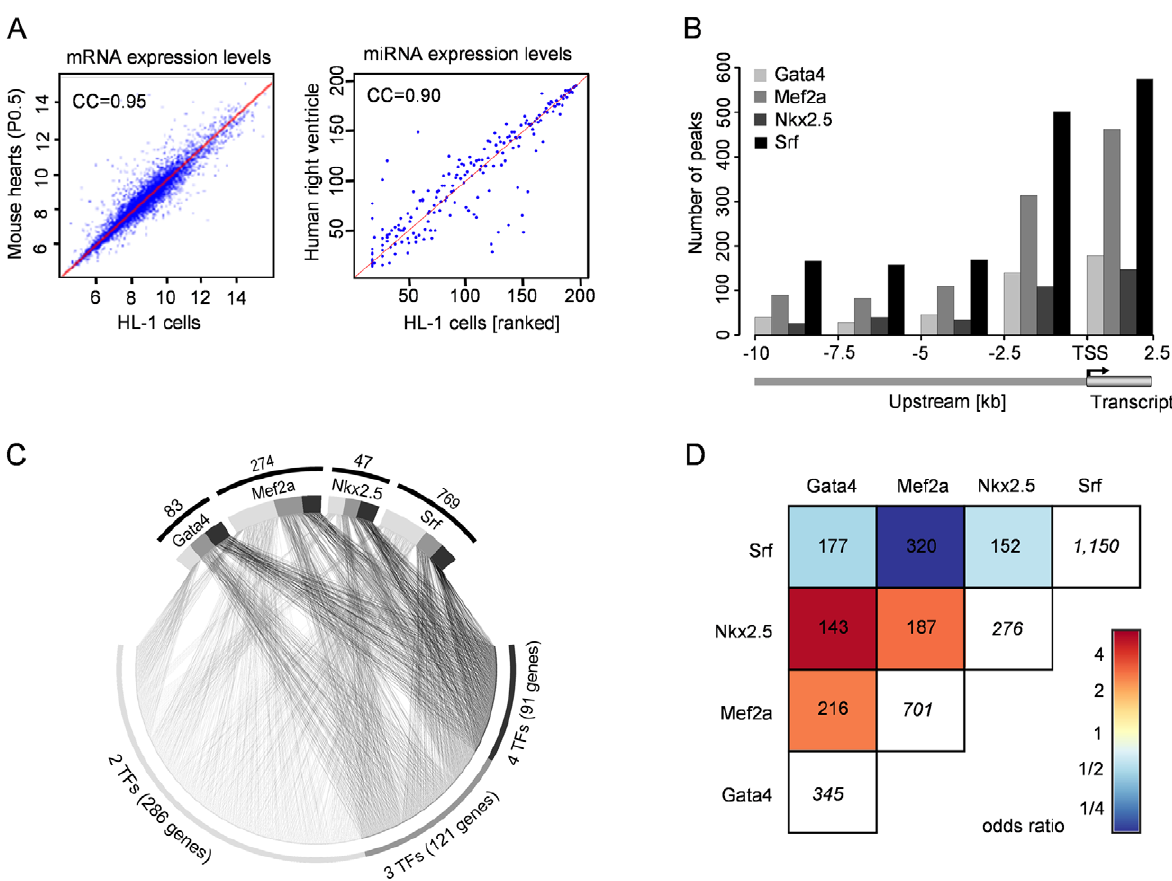
Figure 1. Binding site location and co-occurrence of Gata4, Mef2a, Nkx2.5, and Srf. HL-1 mRNA and miRNA expression profiles are highly comparable to the ones observed in human and mouse hearts. (left) Gene expression levels obtained from HL-1 cells and P0.5 of C57/BL6 mouse heart. (right) Rank-transformed miRNA expression levels in HL-1 cells and human right ventricle. (B) Positional distribution of transcription factor binding sites relative to the transcription start site (TSS). The y-axis shows the number of transcription factor binding sites per transcription factor as bar plots in 2.5kb windows. Most binding sites ( , 75%) are located within close proximity to the TSS. (C) Gata4, Mef2a, Nkx2.5 and Srf frequently bind together. Shown is the combinatorial binding of all four transcription factors to 498 common target genes. 91 target genes were bound by all four factors (black), 121 target genes were bound by three (dark gray) and 286 target genes were bound by two transcription factors (gray). The total number of genes solely bound by a single TF are indicated above the respective TF. (D) Odds ratios of pair-wise contingency tables of the occurrence of transcription factor binding sites at one gene. Total numbers of pair-wise occurrences are given. The numbers in white boxes represent the total number of bound genes for the respective transcription factor. Red indicates positive, blue negative correlation. Gata4 and Nkx2.5 had the lowest number of targets (345 for Gata4, 276 for Nkx2.5) but we observed co-binding to 143 genes and their occurrence is therefore highly correlated. Although Mef2a and Srf bind at 320 genes together, they each have a much higher number of target